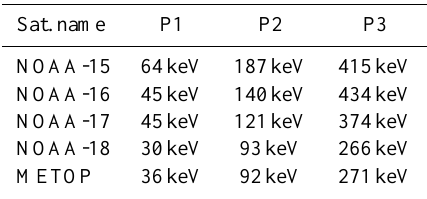
Table 1. Estimated low-energy thresholds for proton 0 ◦ detectors (according to Asikainen et al.,